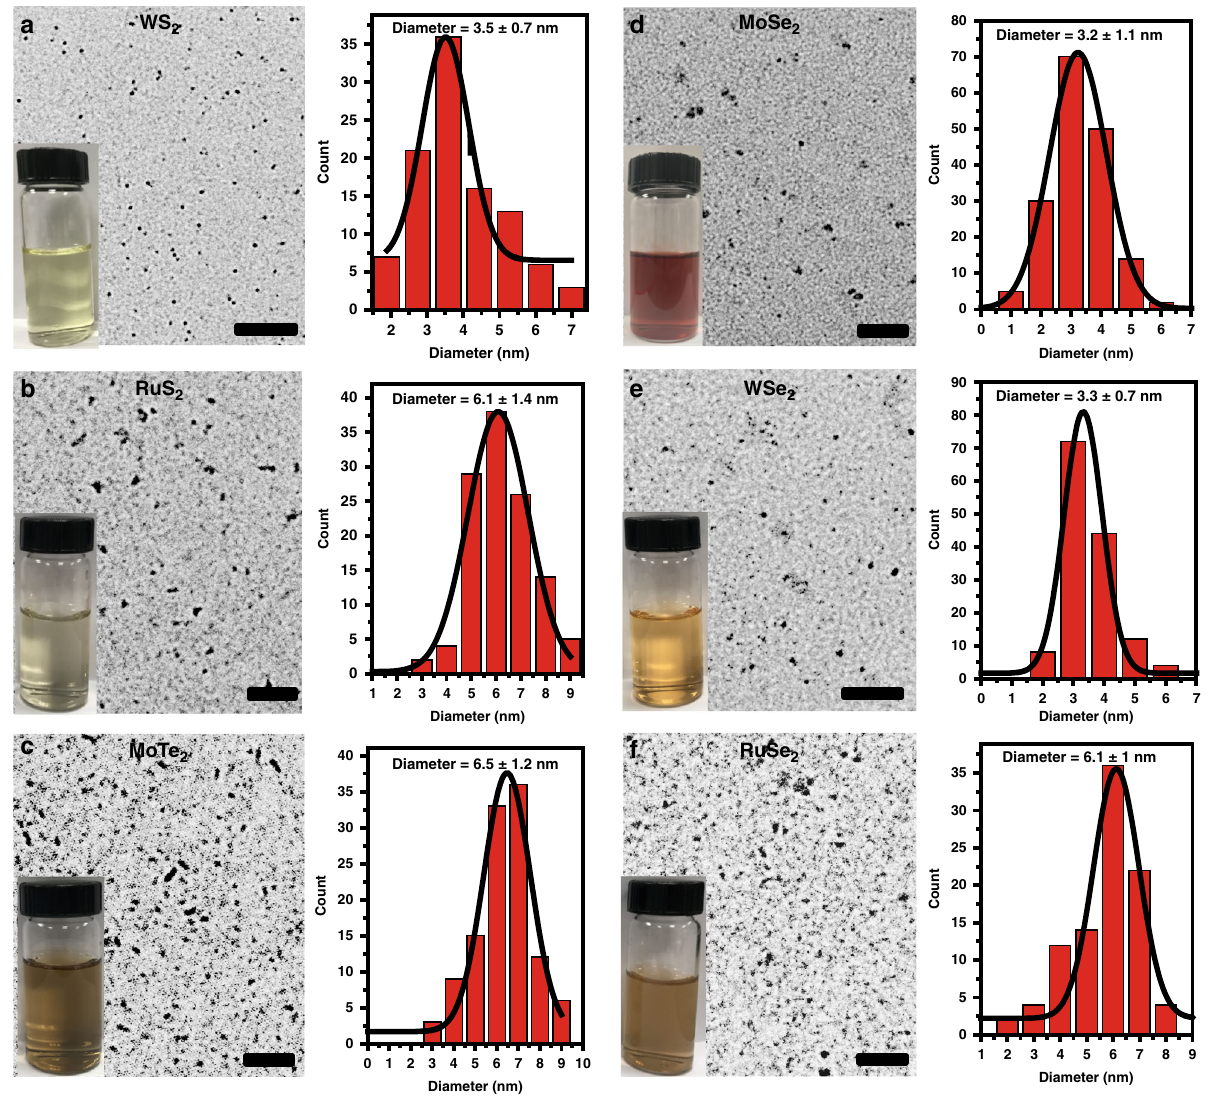
Fig. 4 TEM images of other TMDs QDs synthesized under similarly mild conditions. a – f TEM images of WS 2 , RuS 2 , MoTe 2 , MoSe 2 , WSe 2 and RuSe 2 QDs. Insets: Stable colloidal suspension appearance of TMDs dispersed in aqueous condition. TMDs QDs have consistent sizes. Scale bar: 100